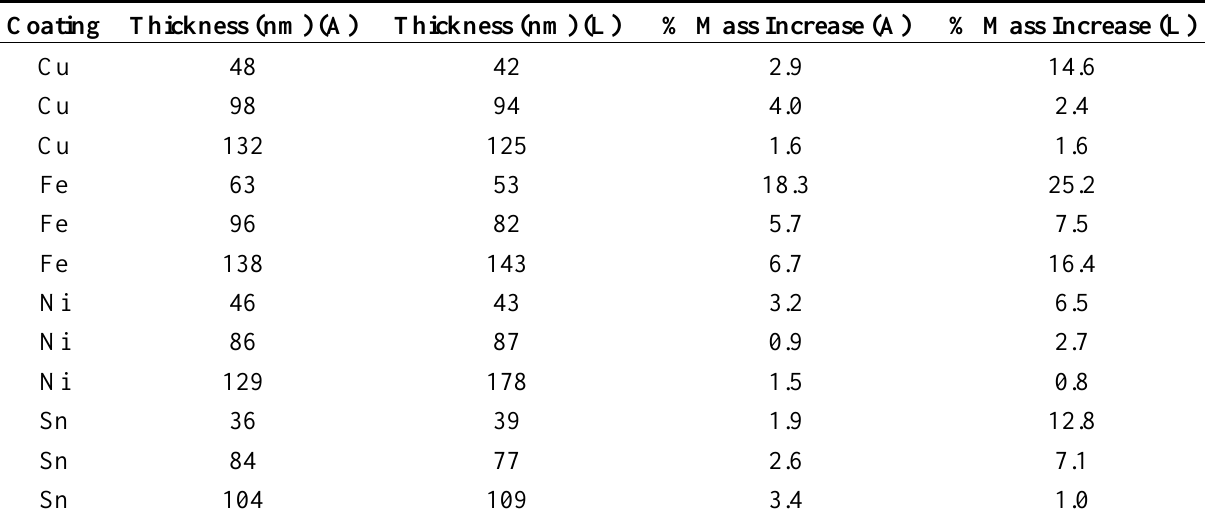
Table 1. Percentage of mass increase measured by PQC sensors in London (L) and Abomey (A) over 140 days between November 2012 and April 2013.